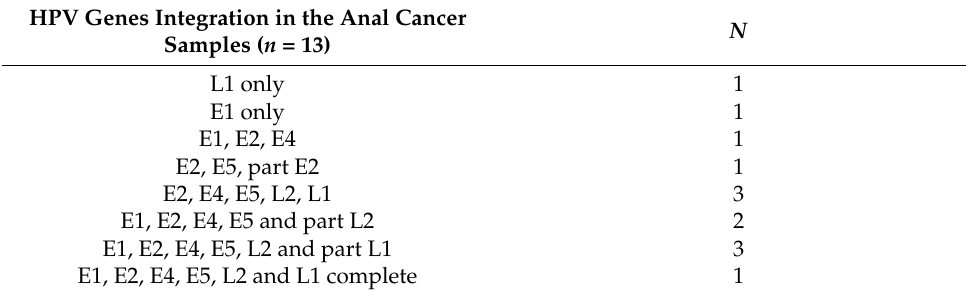
Table 5. HPV integration identified in the anal cancer